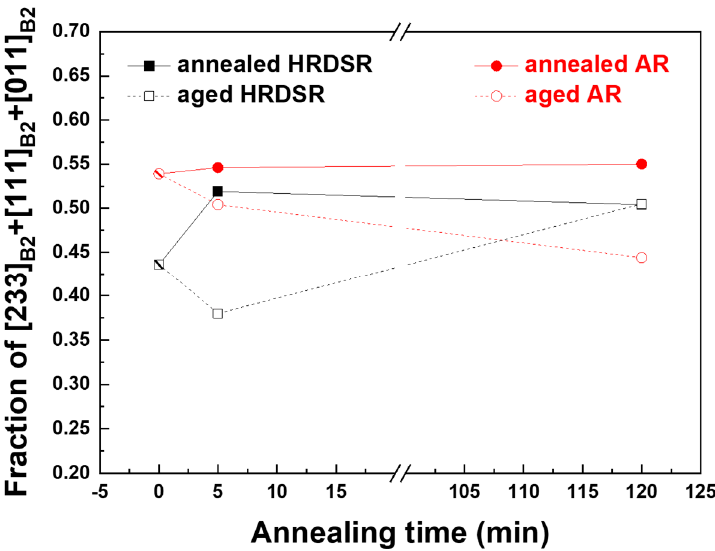
Figure 11. The total fraction of grains with the texture components of [233] B2 //RD, [111] B2 //RD and [011] B2 //RD texture components for the AR and HRDSR samples after annealing or annealing plus aging.